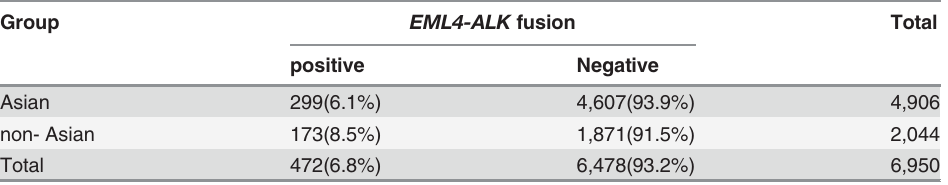
Table 3. Comparison of EML4-ALK mutation rate between Asian and non-Asian.